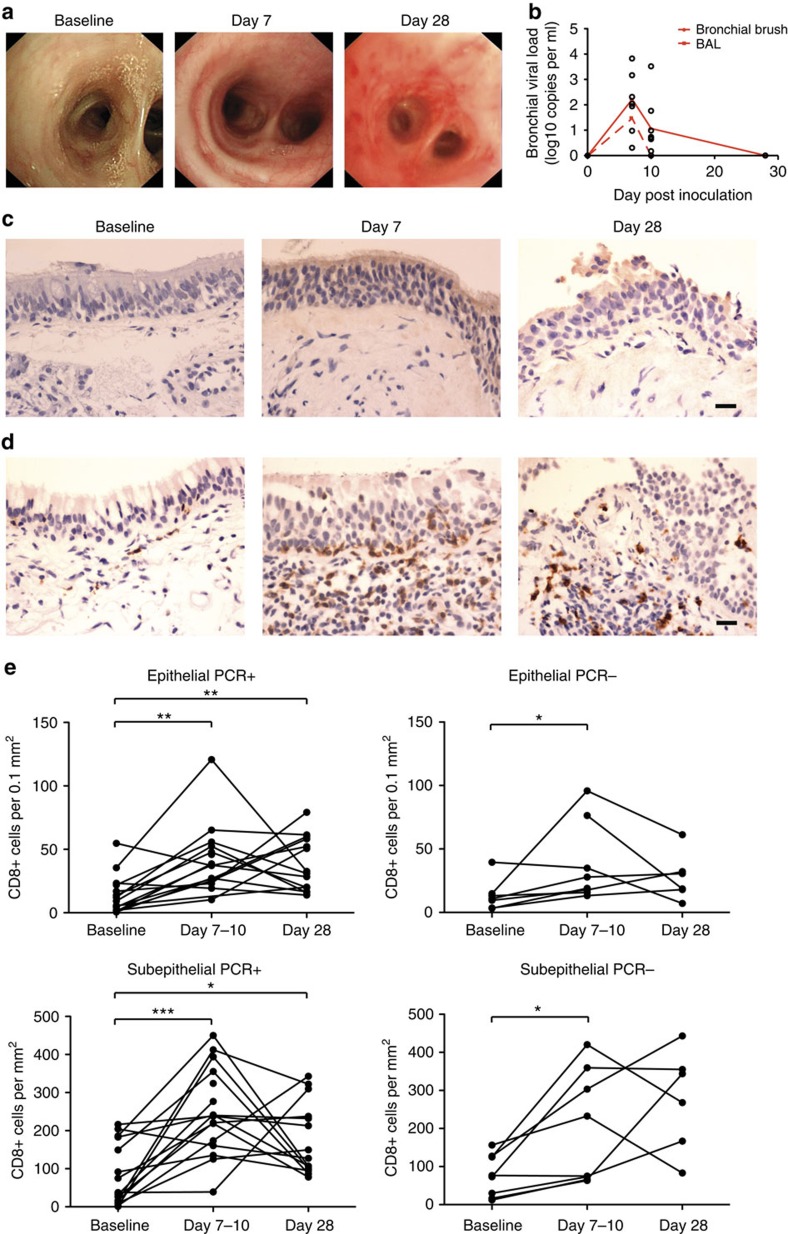
RSV infection of healthy adults causes widespread lower respiratory tract inflammation.Twenty-four volunteers underwent serial bronchoscopic procedures 14 days before inoculation with RSV M37, 7 or 10 days and 28 days post inoculation. (a) The macroscopic appearance of the airways was noted by bronchoscopists blinded to the infection status of the subject. One representative subject is shown. (b) Viral load was determined from bronchial brushings (solid line) and bronchoalveolar lavage (dashed line) by qPCR. Cumulative data are shown as mean±s.e.m. (c) RSV antigen (brown) was detected in bronchial biopsies by immunohistochemistry. One representative donor is shown. (d) CD8+ cells (brown) were identified in bronchial biopsies by immunohistochemistry. Scale bar, 20 μm. (e) CD8+ cells were enumerated in bronchial biopsies of infected individuals (with RSV detected by qPCR in bronchial brushings) and PCR− individuals. Data are presented as number of positive cells per square millimetre of subepithelium or per 0.1 mm2 of epithelium. Significant P values for two-tailed Wilcoxon matched pairs tests are shown (*P<0.05, **P<0.01, ***P<0.001) comparing (with baseline) epithelial PCR+ samples at day 7–10 (P=0.0012) and day 28 (P=0.004), epithelial PCR− samples at day 7–10 (P=0.0469), subepithelial PCR+ samples at day 7–10 (P=0.0004) and day 28 (P=0.0419), and subepithelial PCR− samples at day 7–10 (P=0.0156).